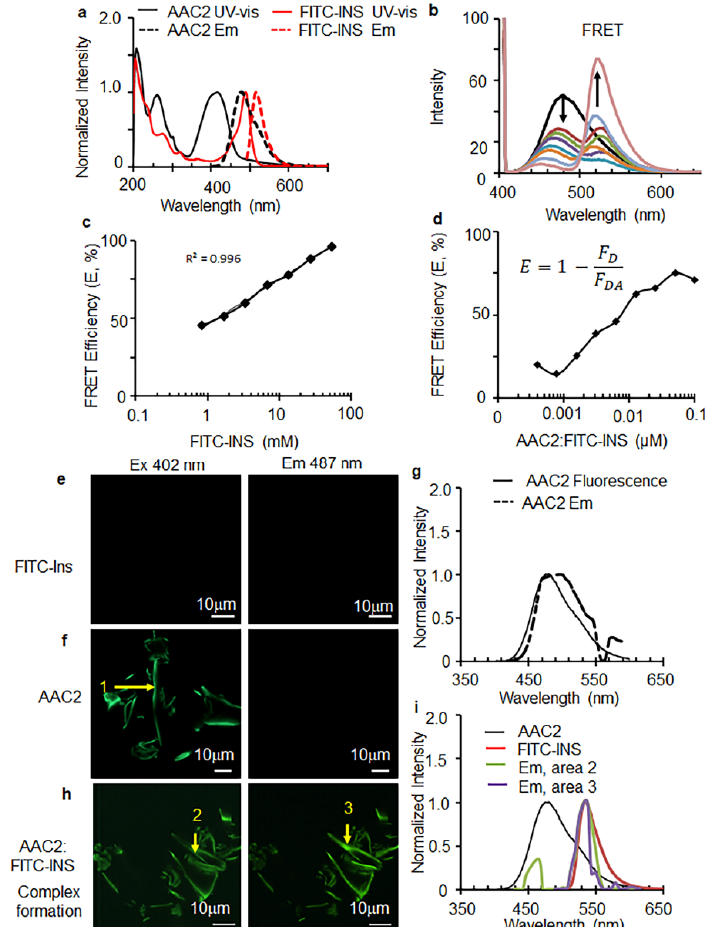
Figure 2. Fluorescence resonance energy transfer (FRET) between interacting AAC2 and Fluorescein (FITC) ‐ labeled INS (FITC ‐ INS). ( a ) Normalized UV ‐ vis absorbance and fluorescence excited (Ex) at 402 nm intensity of AAC2 (1 mM) and FITC ‐ INS (57.3 μ M for UV ‐ vis and 28.65 μ M for fluorescence Ex 487 nm) in PBS to show the spectral overlap. ( b ) Fluorescence spectra of the 1:0.67 AAC2:FITC ‐ labeled insulin mixtures were diluted serially in PBS. ( c ) The percentage of FRET efficiency of each mixture was calculated based on ( b ) using the emission at 479 nm of the mixtures and pure AAC2. ( d ) The percentage of FRET efficiency was calculated based on the emission at 479 nm of fluorescence spectra (Ex 405 nm) of mixtures of 0.1 mM AAC2 with varying concentrations of FITC ‐ labeled insulin to obtain different molar ratios, with a constant concentration of AAC2. Mixtures were incubated at room temperature for 30 min prior to measurement. ( e , f , h ) Confocal images and emission spectra of ( g , i ) of 0.1 mM FITC ‐ INS ( e ), 1 mM AAC2, ( f , g ) and ( h , i ) 10:1 AAC2:FITC ‐ INS (containing 1 mM AAC2) was incubated at room temperature for 30 min prior to imaging. Each sample was excited at both 402 nm (first column) and 487 nm (second column). The emission data were co ‐ plotted with normalized emission, comparing AAC2 and FITC ‐ INS. The dashed line indicates the emission of area 1 in the confocal image.